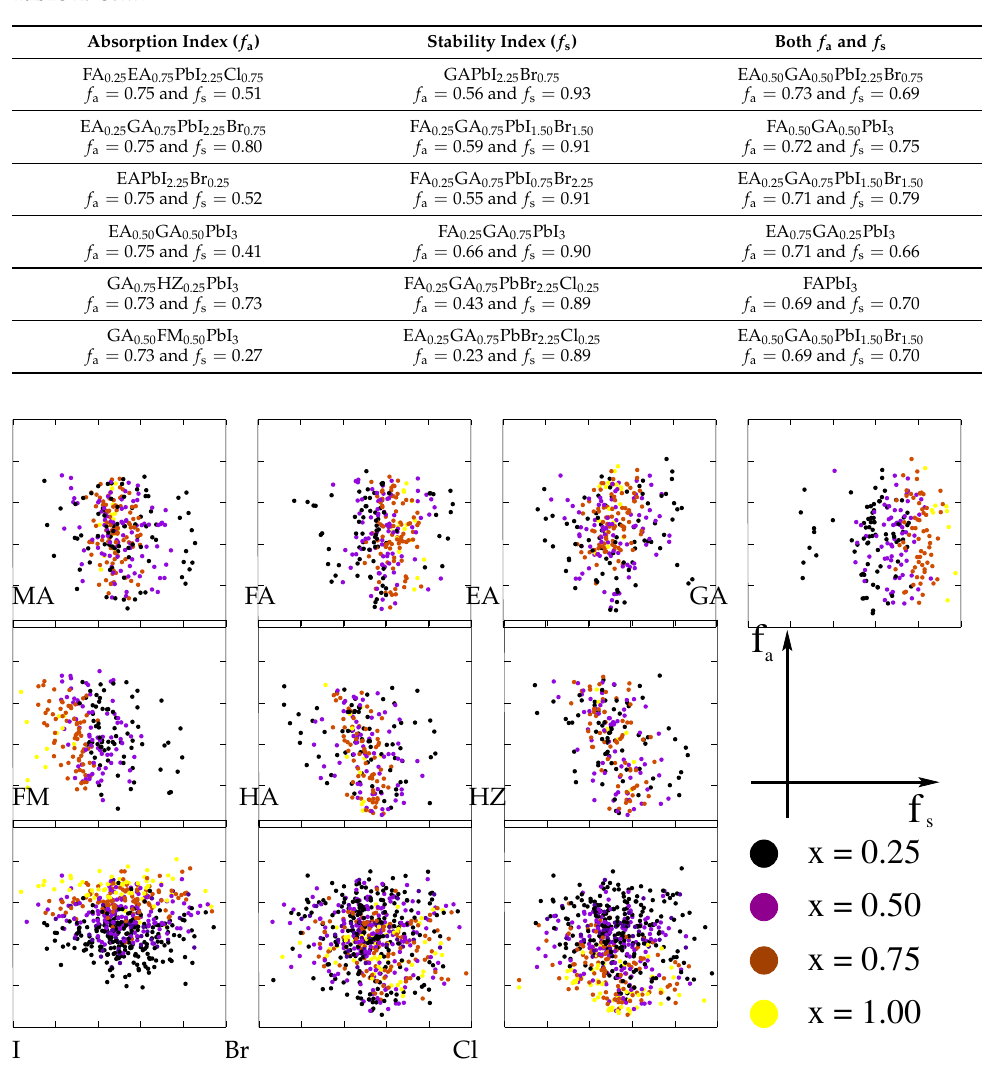
Figure 7. Absorption-stability ( f a − f s ) maps demonstrating individual contributions from the organic cations and halogens, established for the intrinsic degradation mechanism. Stability en- hancements are observed for mixtures containing FA and GA, while large proportions of FM is detrimental. The halogens significantly influence the absorption in accordance with their concentra- tions ( f I a > f Br a > f Cl a ), while Br brings a shift towards higher formation